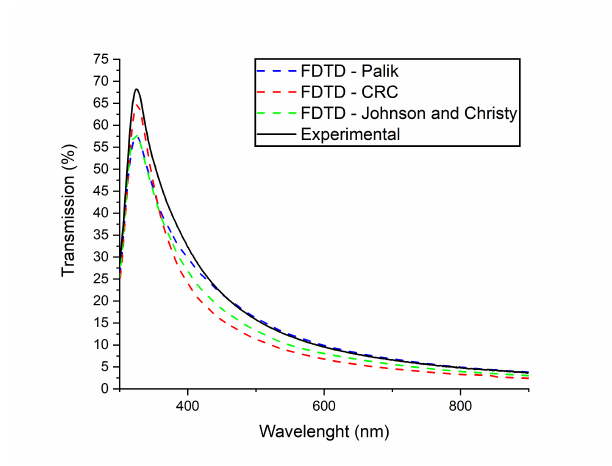
Figure 2: Experimental and simulated transmission of a 30 nm silver film for CRC’s, Palik’s and Jonhson and Christy’s